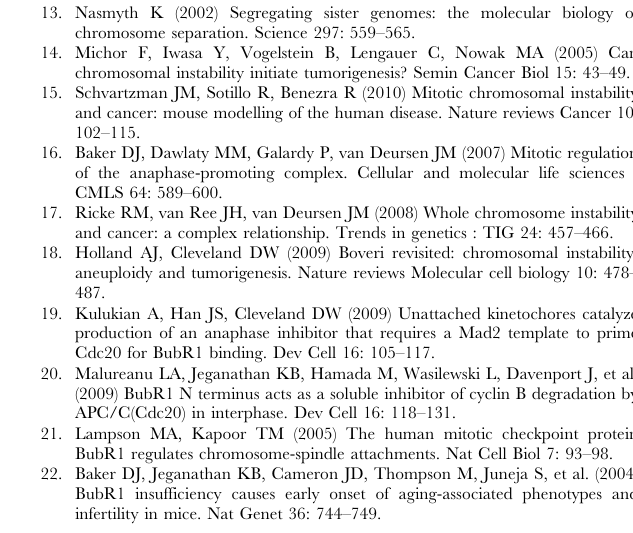
Figure S1 Analysis of cell cycle inhibition before and after reprogramming. (A) Growth curves of P5 MEFs. Curves were generated from three independent clones per genotype seeded in duplicates. Error bars represent SD. (B) Western blot analysis of wildtype and BubR1 H/H iPSC extracts probed for p53 and p16.